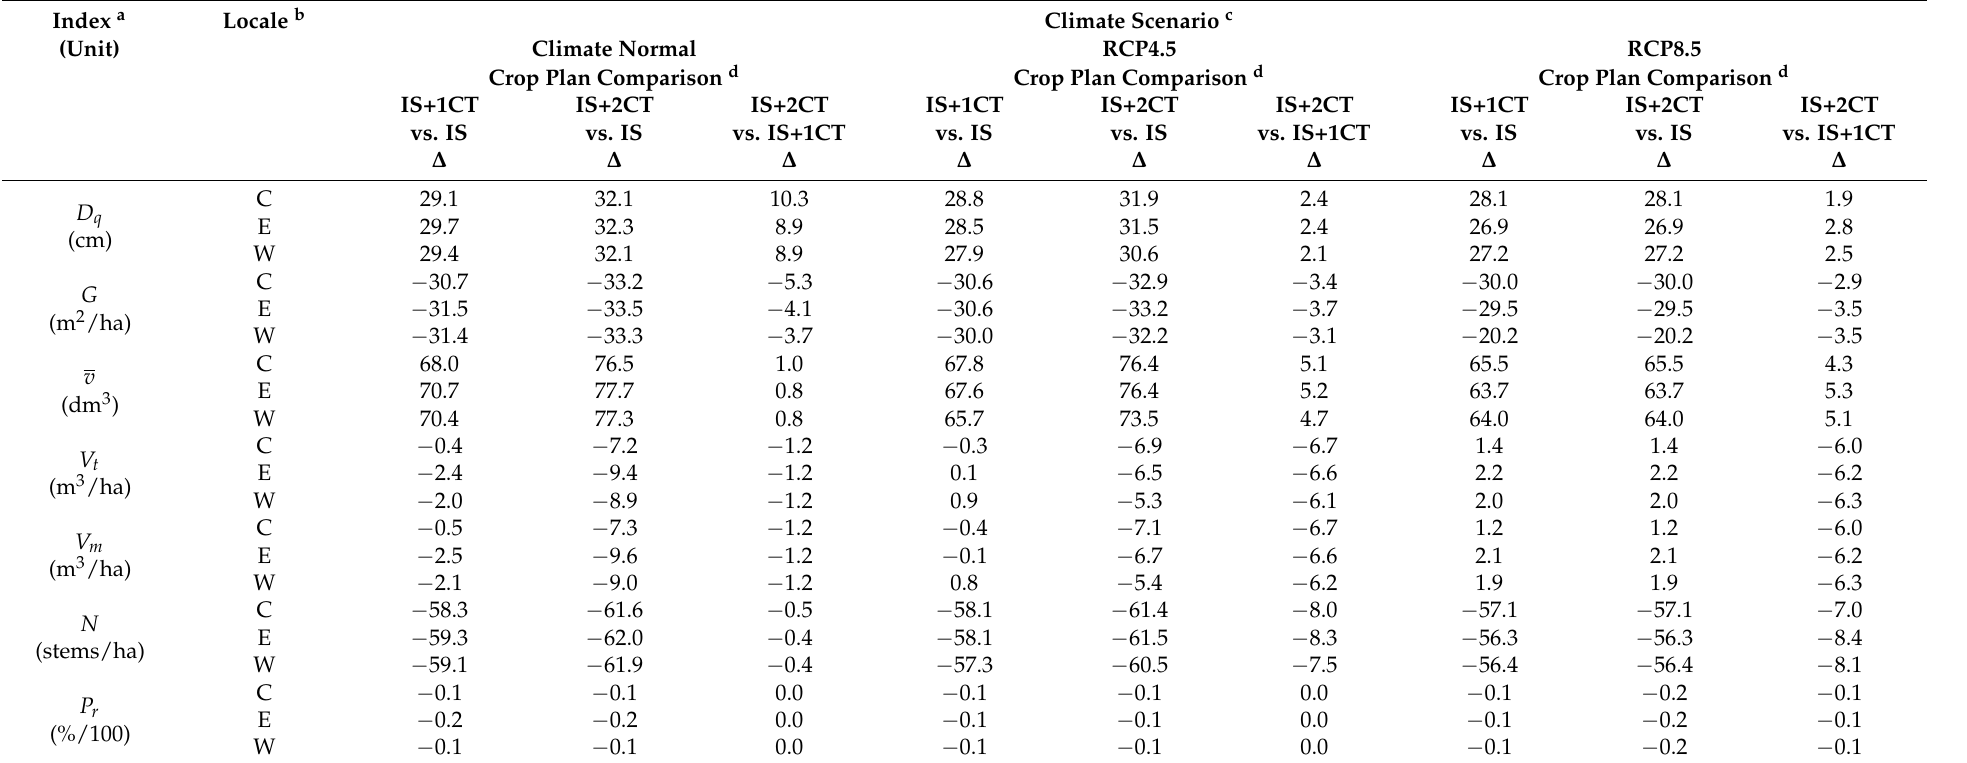
Table 4. Climate-specific silvicultural effectiveness comparisons among the selected red pine crop plans for plantations situated in north-central (Thessalon), north-eastern (Kirkland Lake) and north-western (Thunder Bay) Ontario: SSDMM-derived rotational yield comparisons for three crop plans growing under three climate change